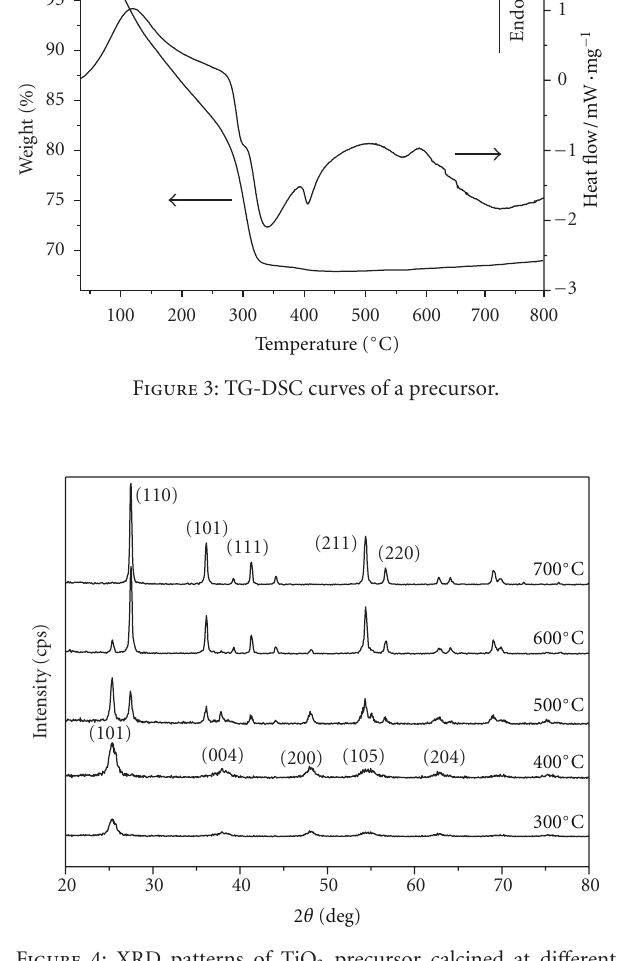
Figure 4: XRD patterns of TiO 2 precursor calcined at di ff erent temperatures.